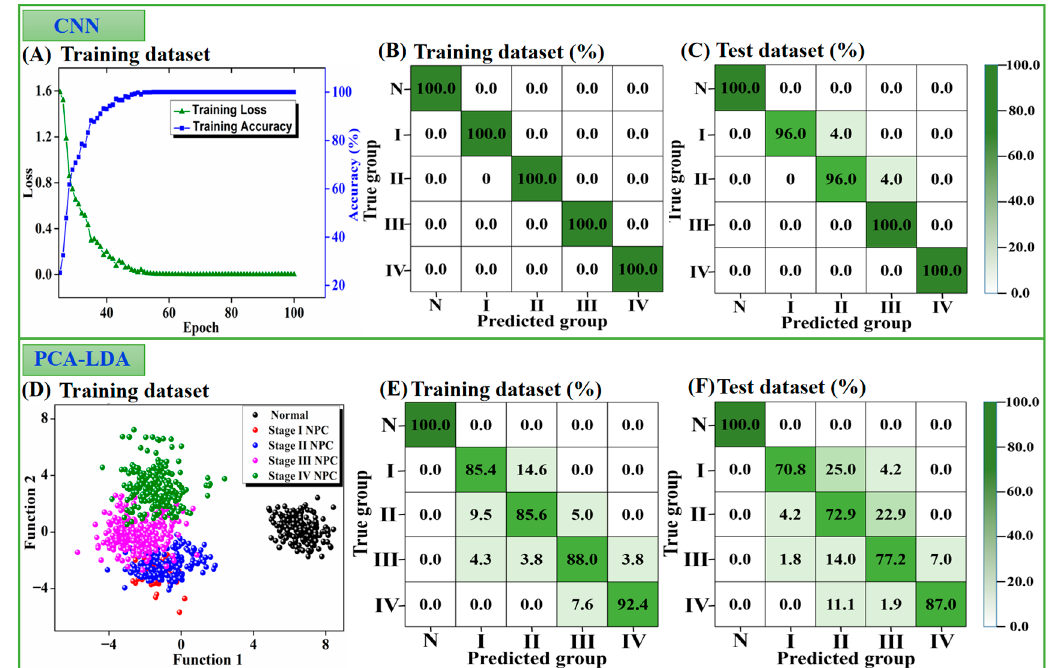
Figure 6. ( A ) Loss and accuracy curves of the CNN model on the training set. ( B ) Training accuracy and ( C ) testing accuracy of the CNN method for healthy and stage I, II, III, and IV NPC groups on the training and test set, respectively. ( D ) Scatter plot of the discrimination scores by PCA ‐ LDA on the training set. ( E ) Training accuracy and ( F ) testing accuracy of PCA ‐ LDA for the five groups.